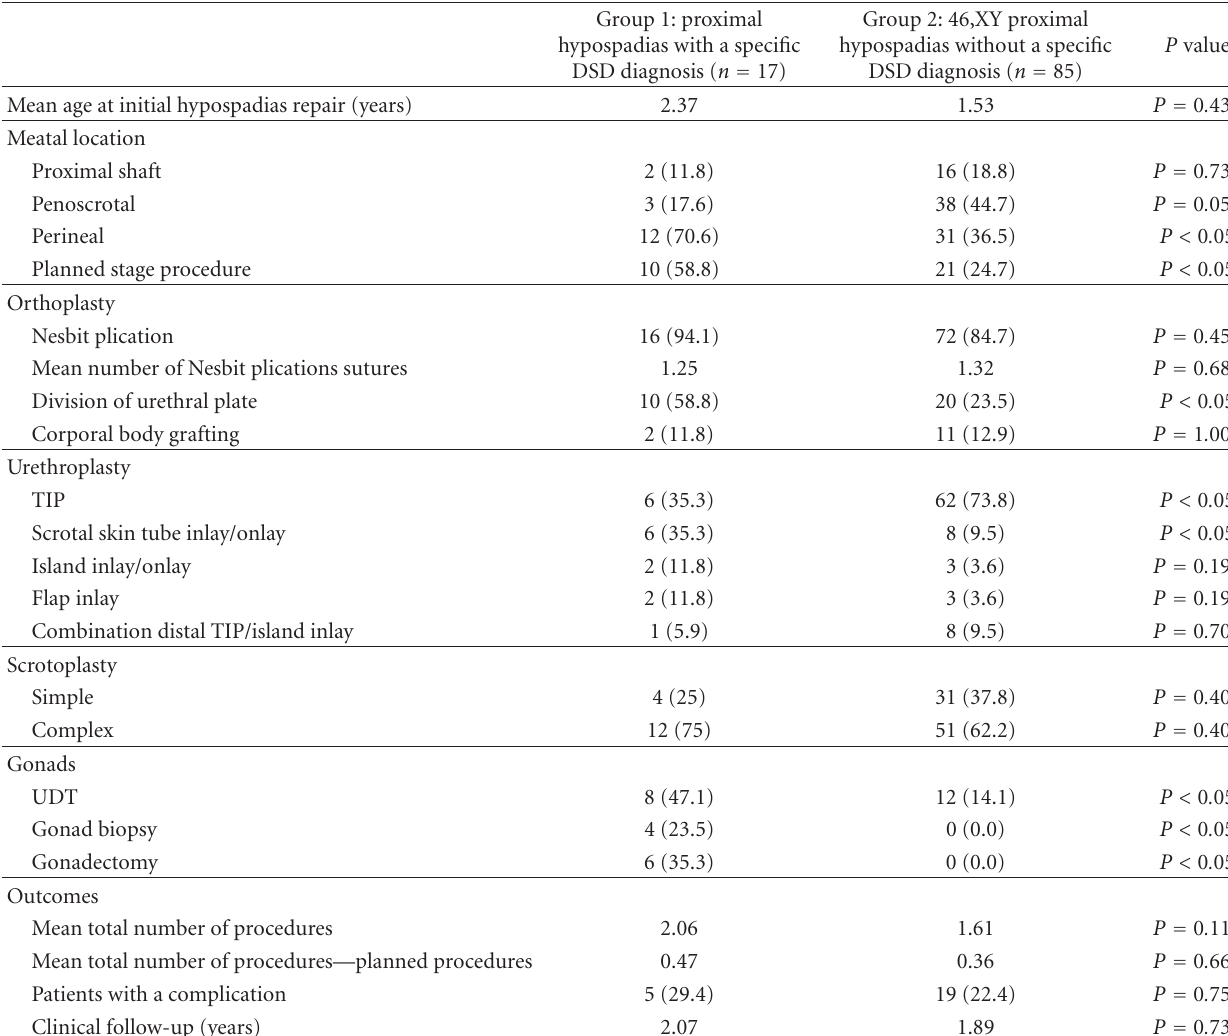
Table 2: Anatomy, procedure, and outcomes